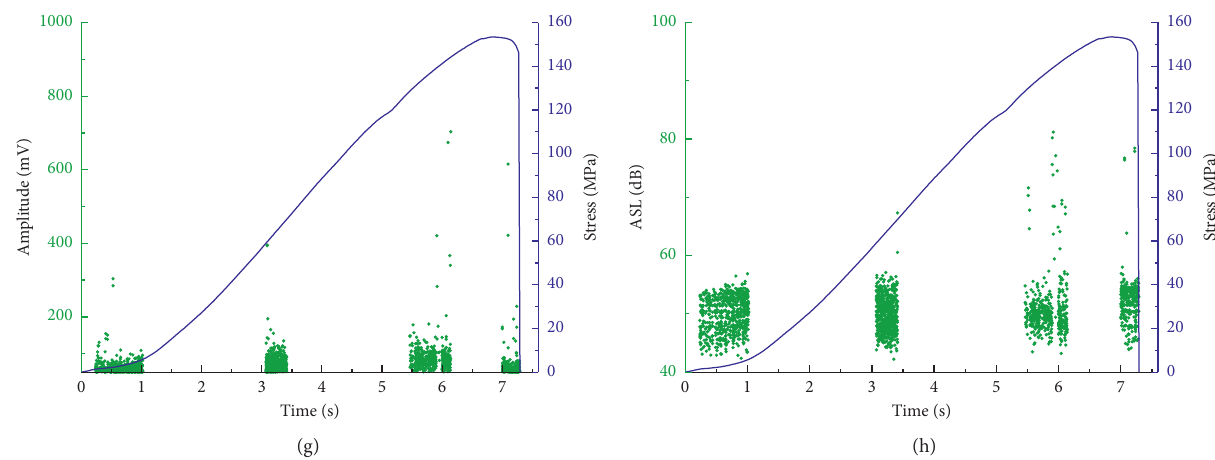
Figure 6: AE amplitude and ASL of the karst limestone under different strain rates. (a) Amplitude of AE signals at 5 × 10 − 6 s − 1 . (b) ASL of AE signals at 5 × 10 − 6 s − 1 . (c) Amplitude of AE signals at 2 × 10 − 5 s − 1 . (d) ASL of AE signals at 2 × 10 − 5 s − 1 . (e) Amplitude of AE signals at